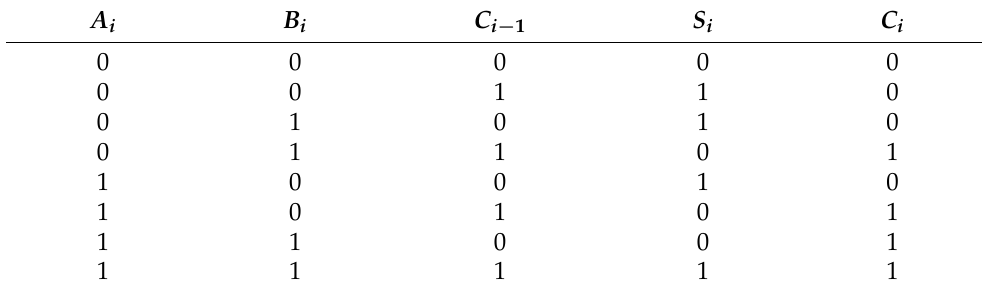
Figure 12. The test results of the half adder. Table 6. The truth table of the full adder.